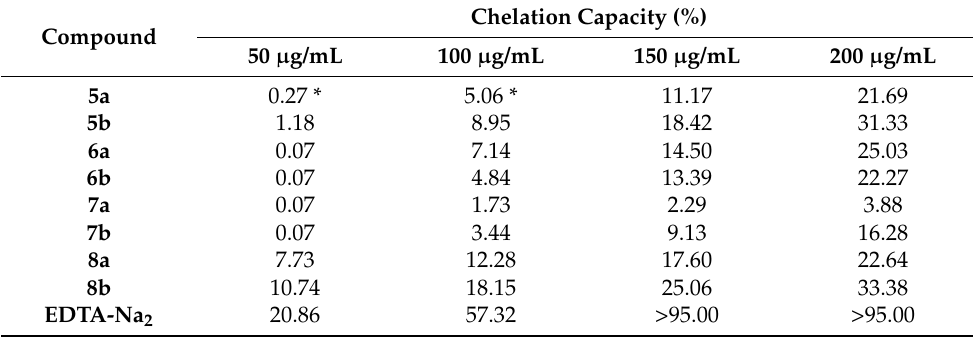
Table 5. Results of the ferrous ions chelation capacity evaluation. Compound